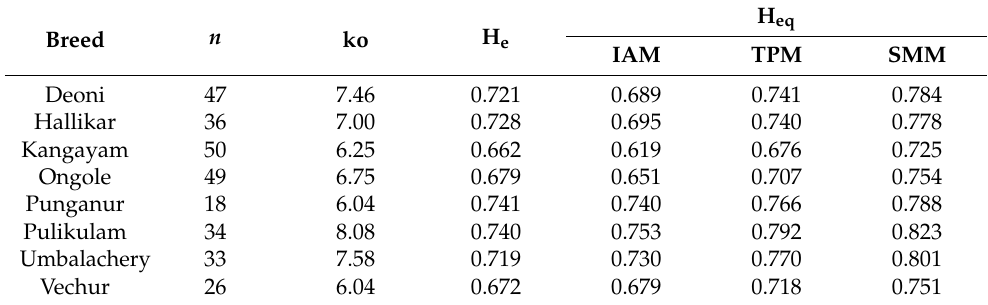
Table 1. Breed wise allelic diversity, mean expected HWE heterozygosity and mean expected mutation drift equilibrium heterozygosity under assumption of different models of microsatellite mutation. Breed n ko H e